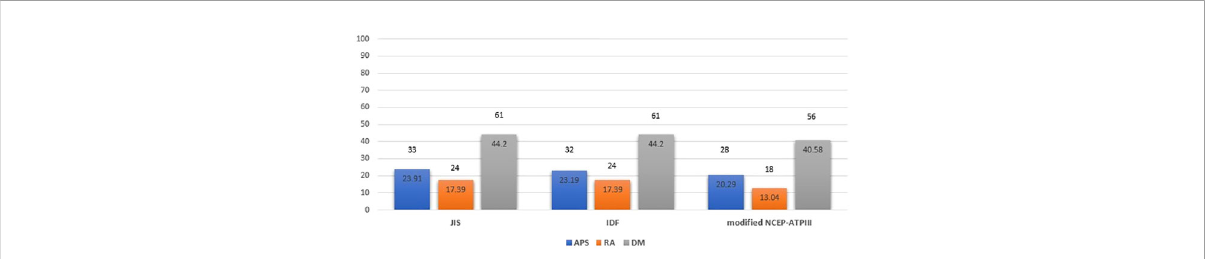
FIGURE 1 Metabolic syndrome prevalence in APS, RA and DM patient groups based on JIS, IDF and modi fi ed NCEP-ATPIII criteria (Percentages and absolute numbers are noted) # Comparison for APS versus RA patients: p=0.181, p=0.231, p=0.106 based on JIS, IDF and modi fi ed NCEP-ATPIII criteria respectively. Comparison for APS versus DM patients: p<0.001 for all criteria. Comparison for RA versus DM patients: p<0.001 for all criteria. Comparison for APS versus RA versus DM patients: p<0.001 for all criteria. APS, Antiphospholipid syndrome; RA, Rheumatoid arthritis; DM, Diabetes mellitus; JIS, Joint Interim Statement; IDF, International Diabetes Federation; NCEP-ATPIII, National Cholesterol Education Program Adult Treatment Panel